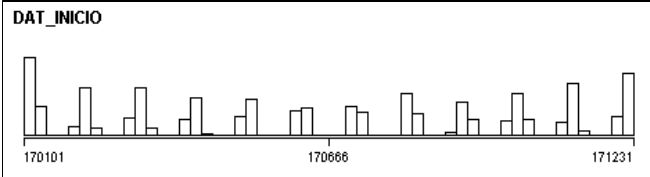
Figure 3: Graphic of the Interruption frequency during one year by month.